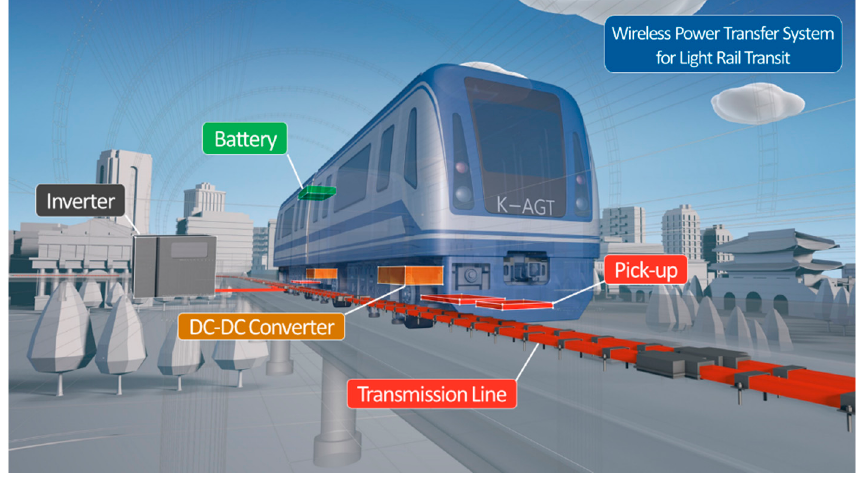
Figure 1. WPT system for light rail transit. Table 2. Specifications of WPT system for light rail transit.